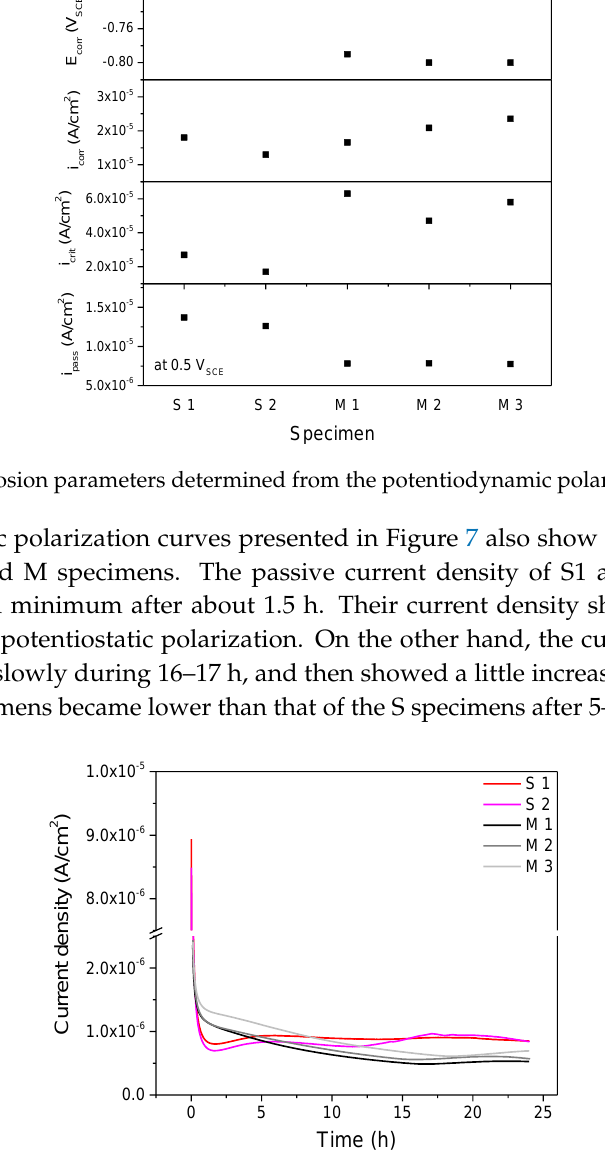
Figure 8. Passive current density after 24 h. The type and concentration of point defects in the passive film were examined using a Mott– Schottky analysis. The authors of this study point out that the Mott–Schottky analysis has limitations as applied to passive films, because a passive film is not a well-defined semiconductor. Therefore, several assumptions are employed commonly and the results of the analysis are interpreted with care [53–55]. In particular, the quantitative property derived from the Mott–Schottky analysis (i.e., the donor density in this study) cannot be directly compared with that of other alloys. Nevertheless, the relative value of the donor density within the boundary of this study can be discussed. The Mott–Schottky plots (Figure 9) of all specimens showed similar behavior, indicating a linear region with a positive slope between −0.3–0.3 V SCE . This means that these specimens had passive films with an n-type semiconductivity. The donor density, which implies the concentration of oxygen vacancy in the passive film [17], was determined by the Mott–Schottky relationship, as shown in Equation (1): (1) where C is the capacitance of the space charge layer, ε is the dielectric constant of the passive film, ε 0 is the permittivity of the vacuum, e is the charge of an electron, N D is the donor density, E app is the applied potential, E FB is the flat band potential, k is the Boltzmann constant, and T is the temperature. ε 0 of the passive films on the specimens in this study was presumed to be 15.6, as accepted usually for the passive film of steels [20,46–48].